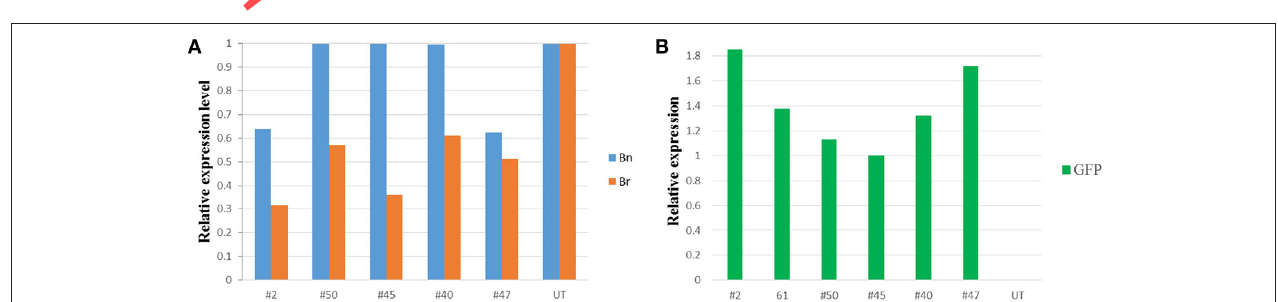
FIGURE 4 | Bar chart of qRT-PCR of native CENH3 and GFP-synthetic CENH3 in transgenic B. juncea . (A) Suppression of native CENH3 genes of B. juncea (Both B. rapa - and B. nigra -like transcripts), (B) Expression of GFP-synthetic CENH3. Bn- B. nigra -like transcript, Br- B. rapa -like transcript.